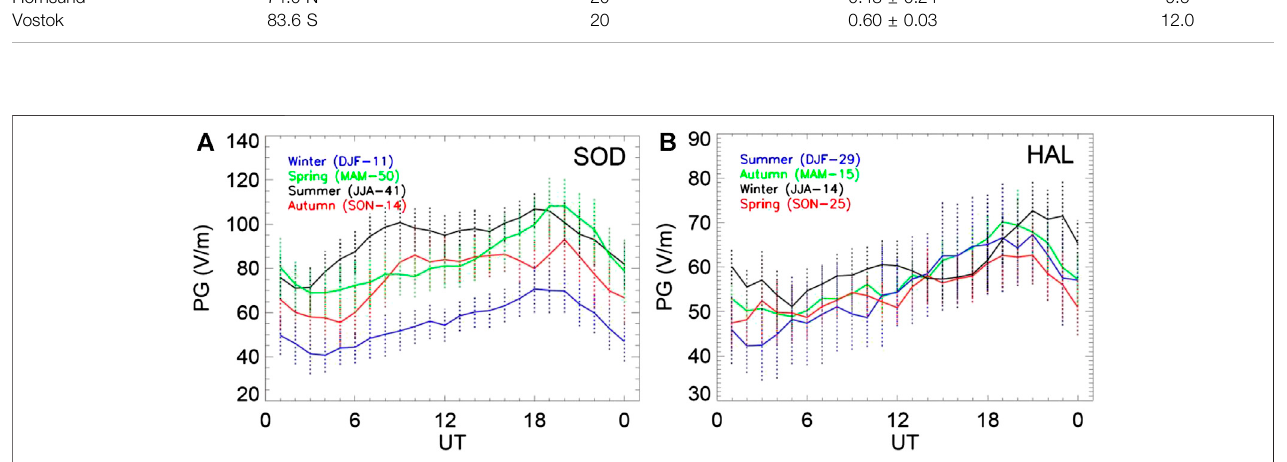
FIGURE 7 | Mean diurnal variation in PG for fair weather conditions as a function of season for (A) SOD and (B) HAL stations. The error bars are one standard deviation, and the legend gives the months as well as the number of points included for each season of the year.